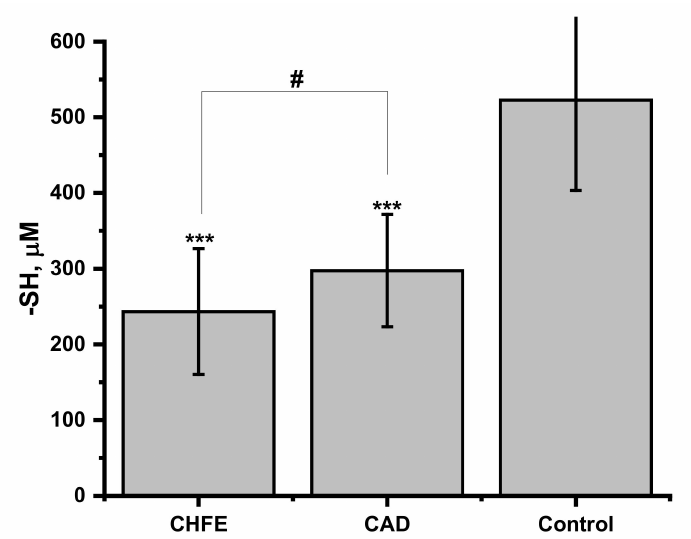
Figure 2. The assessment of free thiol groups in blood plasma from CHFE ( n = 7), CAD ( n = 8) and control ( n = 15) participants. Measurements of the samples were performed in triplicates. The data represent mean ± SD. The values of *** p < 0.001 vs. controls, were considered significant; # p >